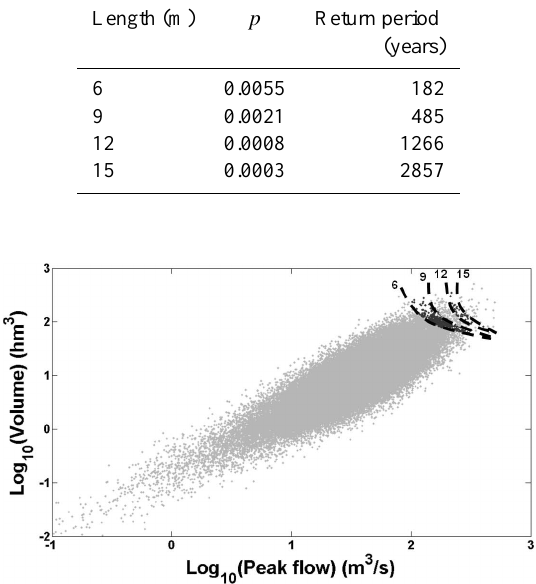
Table 6. Exceedance probabilities ( p ) of a reservoir water level of 894m for different spillway crest lengths in the Santillana reservoir. Exceedance probabilities were transformed into return periods.